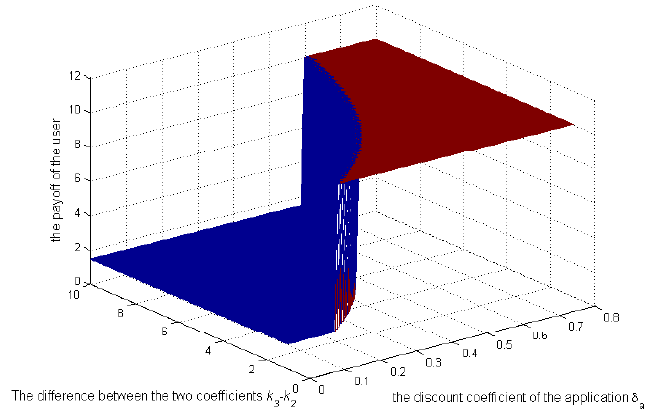
Figure 9. Impact of k 3 − k 2 and δ a on the user’s payoffs.